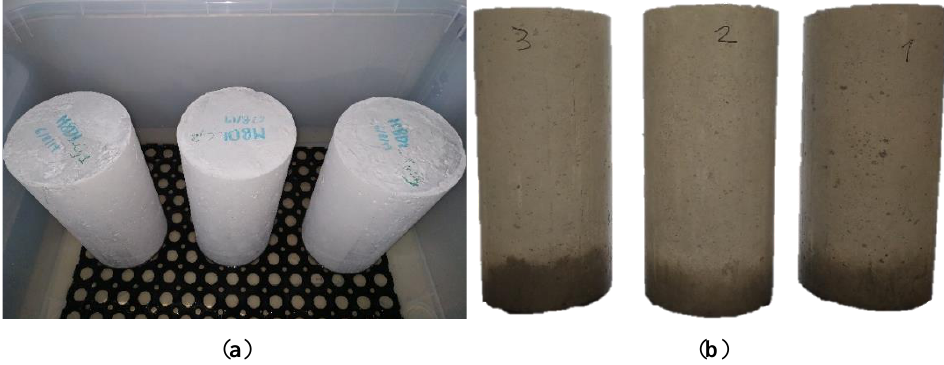
Figure 7. ( a ) Set-up for water absorption test by capillarity; ( b ) representative specimens after a certain time of exposure to water, during the absorption test by capillarity. Table 13. Results of water absorption tests by capillarity obtained for the reference mixture REF2. Time (min 0.5 )